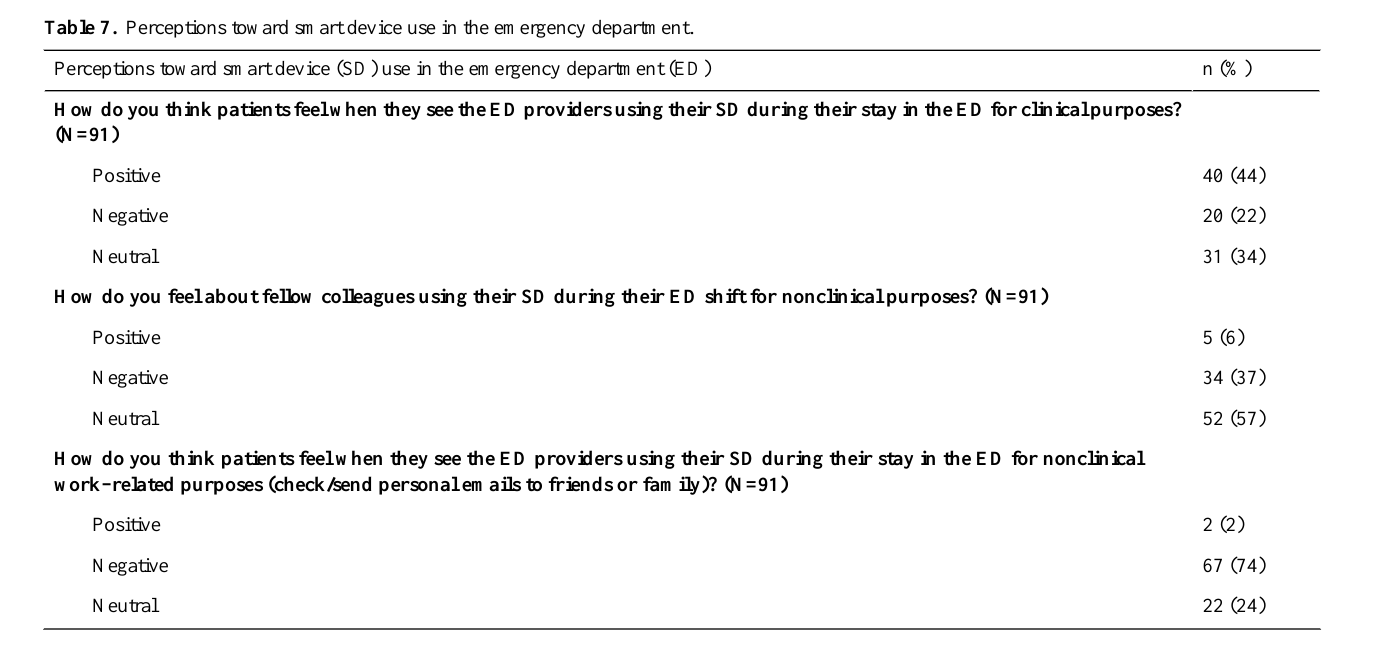
Table 8. Opinion and attitudes toward using smart devices in the emergency department and the need for a code of conduct.